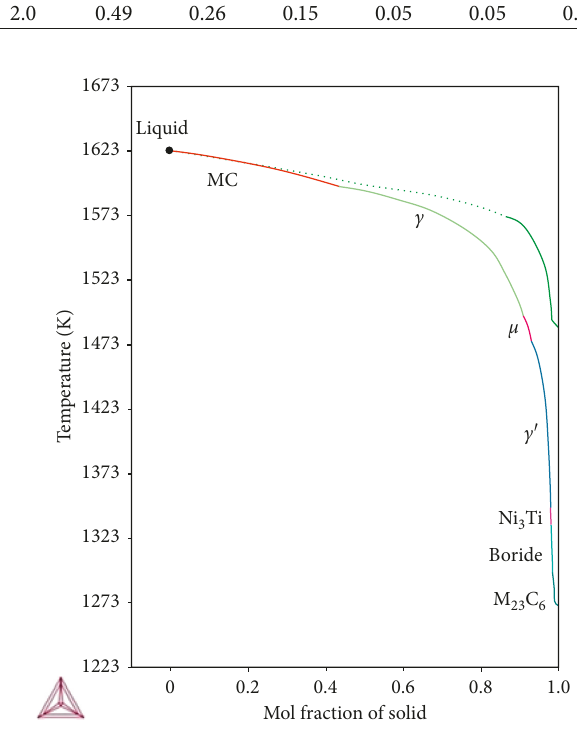
Figure 3: Temperature versus mol fraction of solid for the IN-792